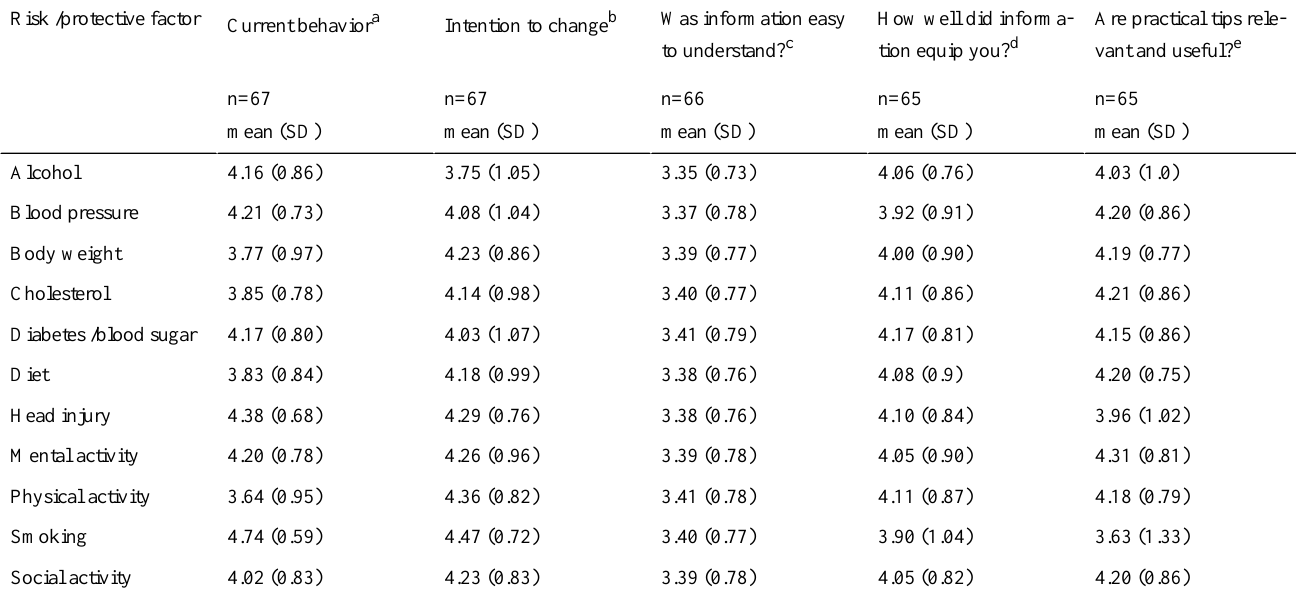
Table 6. Mean (SD) ratings for questions asked in relation to specific risk or protective